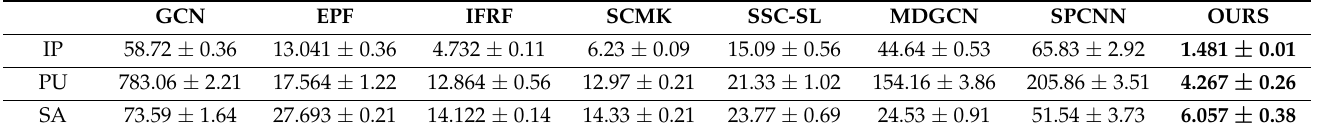
Table 5. Running time (seconds) of eight classification methods on three